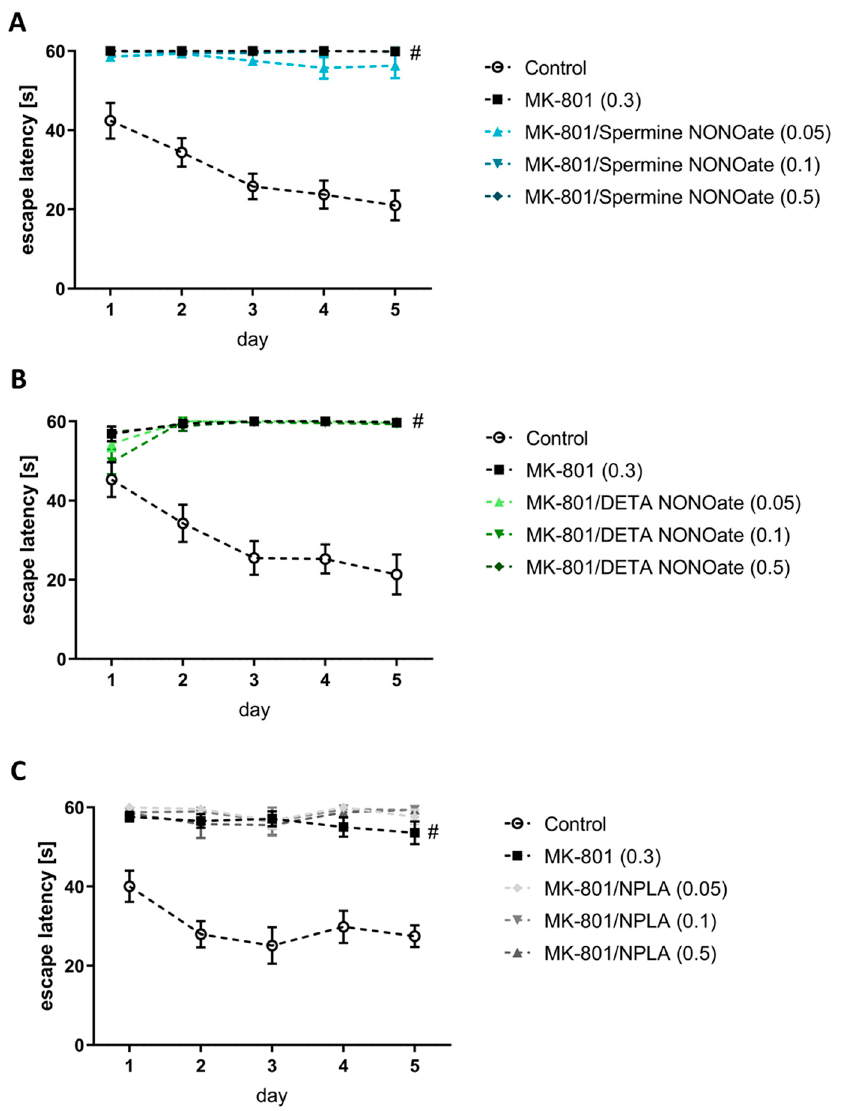
Figure 4. The effects of spermine NONOate ( A ), DETA NONOate ( B ), and NPLA ( C ) on the MK-801 (0.3)–induced amnestic effect on the acquisition of spatial memory in the MWM of CD1 mice. The values are expressed as the means ± SEM. # p < 0.001 indicates the difference between MK-801-treated mice vs. the respective vehicle (N = 8–10) (please consider that in Figure 4a lines, of MK-801/spermine NONOate (0.1 mg/kg) and MK-801/spermine NONOate (0.5 mg/kg) are not visible because they ideally overlap with the MK-801 line alone).